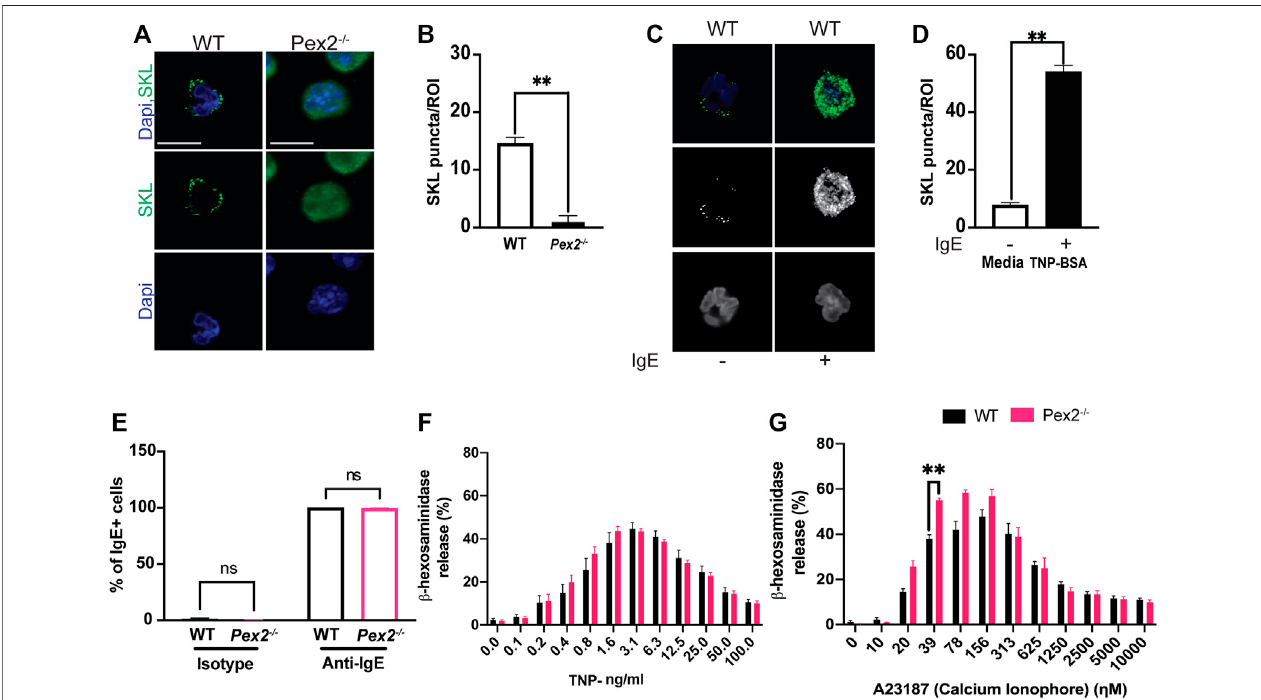
FIGURE 1 | Peroxisome do not alter MCs granularity and degranulation: (A) WT and Pex2 − / − BMMCs were stained for peroxisome (SKL, Green) and nuclei (Dapi, Blue). Scale bar, 10 µm. (B) Peroxisomes number was de fi ned by automated counting of SKL-positive puncta per region of interest (ROI). The graph bars represent the number of SKL-positive puncta in stack z = 3. N = 25 cells. For each cell 22 stacks were acquired. (C) Indirect immuno fl uorescence of WT and Pex2 − / − BMMCs were stained for peroxisome (SKL, Green) and nuclei (Dapi, Blue). Scale bar, 10 µm. (D) Peroxisomes number was de fi ned by automated counting of SKL-positive puncta. The graph bars represent the number of SKL-positive puncta in stack z = 3. N = 25 cells. For each cell 22 stacks were acquired. (E) WT and Pex2 − / − BMMCs were tested for their ability to bind to the anti-TNP speci fi c IgE by fl ow cytometry. (F) Percentageofbeta-hexosaminidasedegranulationwasassessed upon15 minofTNP-BSAIgE-mediateddegranulationand (G) A23187calciumionophore-mediated degranulation. Graphs represent the average of three independent experiments ±SEM. Statistical analyses were performed using a non-parametric t -test comparing between Pex2 − / − and WT BMMCs. ** p < 0.01, ns: not signi fi